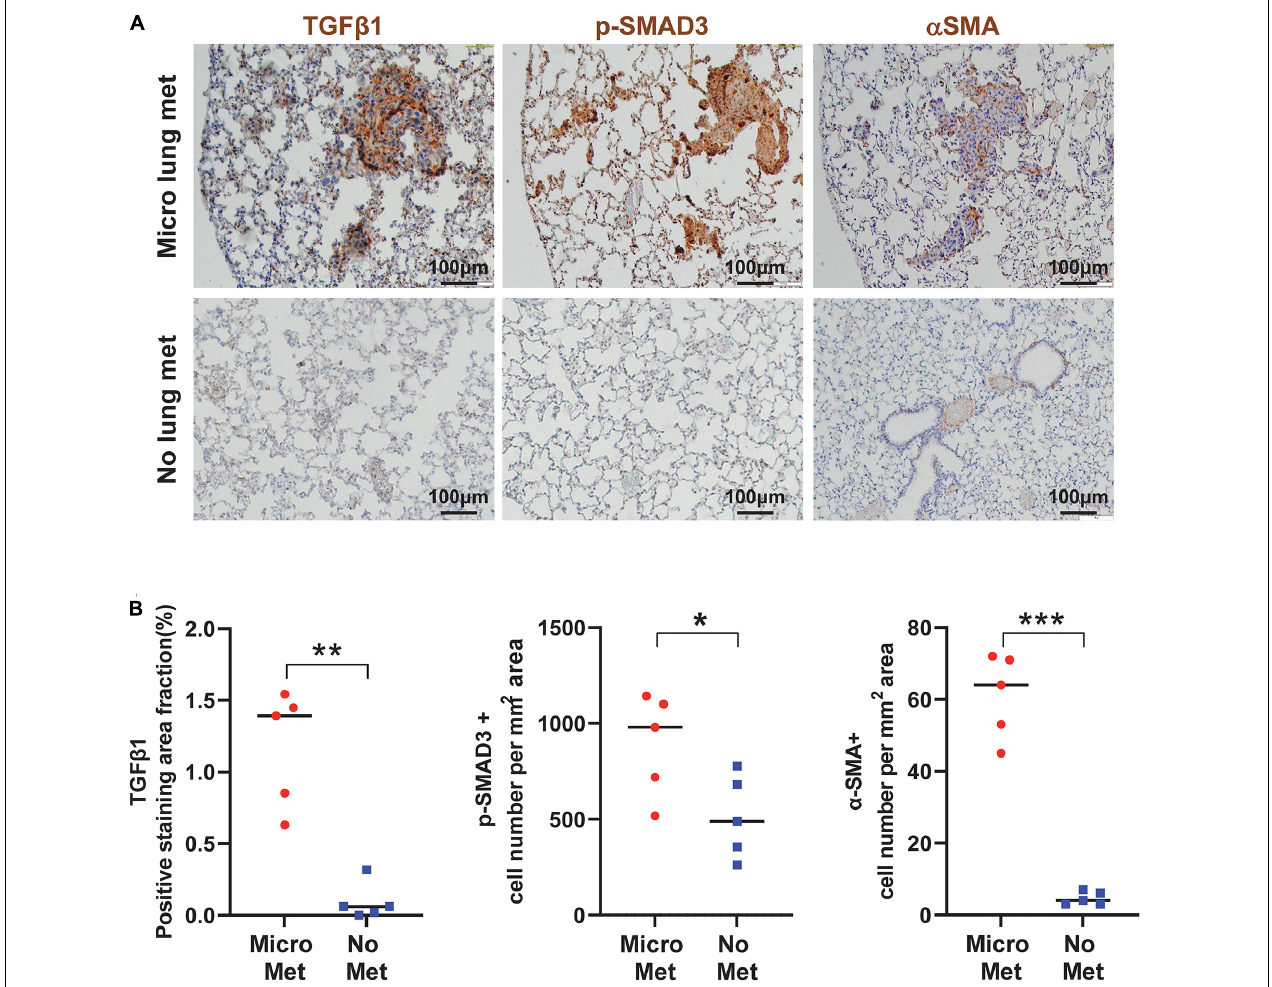
FIGURE 8 | TGF β signaling is activated in the primary tumor associated with metastasis and the metastatic niche. (A) Representative IHC staining of TGF β 1, p-SMAD3, and α SMA in lungs from mice with or without micrometastasis at 4–5 weeks after B931 cell flank transplantation. Scale bar: 100 µ m. (B) Quantification of TGF β 1, p-SMAD3, and α SMA in lungs with or without B931 micrometastasis. * P < 0.05, ** P < 0.01, *** P <